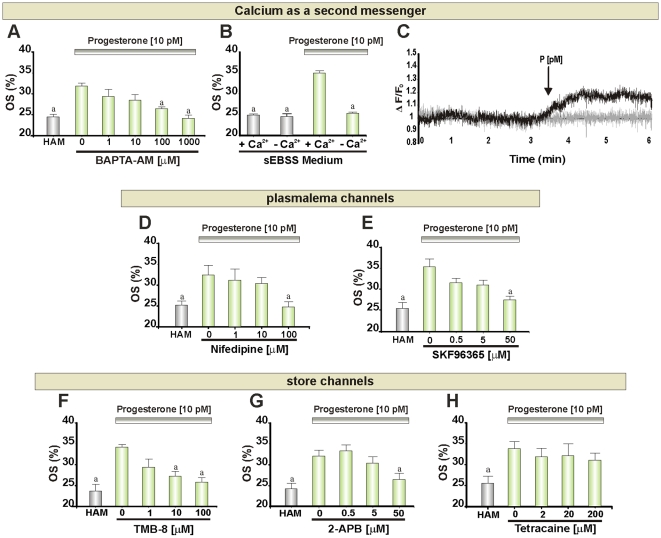
Calcium as a second messenger for sperm chemotaxis.
A, B, D, E, F, G and H: Percentage of oriented spermatozoa (OS) towards 10 pM P gradient after treating the cells with BAPTA-AM (1 min), sEBSS culture medium with and without extracellular calcium, Nifedipine (1 min), SKF96365 (1 min), TMB-8 (1 min), 2-APB (15 min) and Tetracaine (15 min), respectively. C: Ca2+ signal (change in Oregon green 1 BAPTA florescence) in immobilized human spermatozoa, black line shows the mean of cells that responded to a step application of pM P and gray line shows the mean of those cells in which no response was detectable. Black arrow marks time of arrival of P in the imaging chamber. HAM was assayed as a negative control. Each bar shows mean ± SEM. a Significant differences vs. without inhibitor (p<0.05).